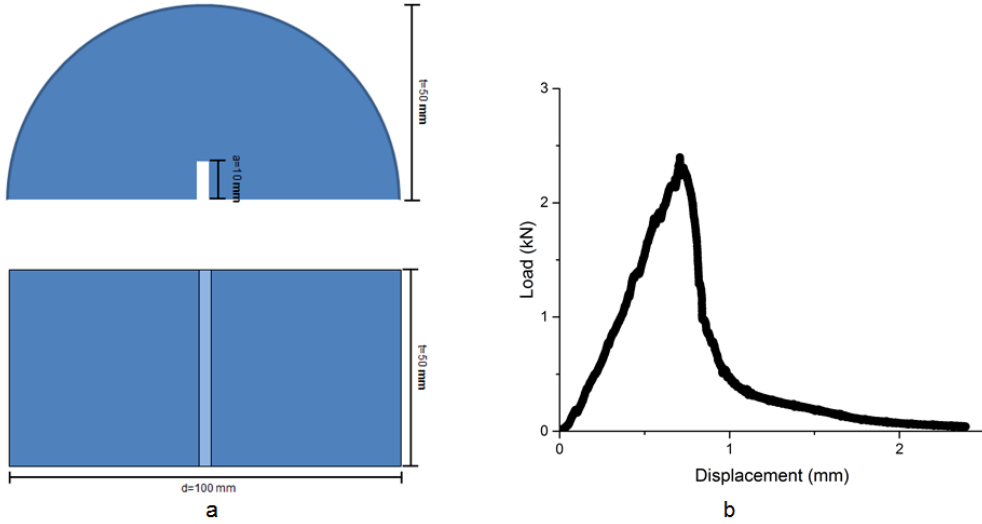
Figure 5. ( a ) Geometry information of the semi-circular porous asphalt specimens and ( b ) load vs displacement curve from SCB tests.